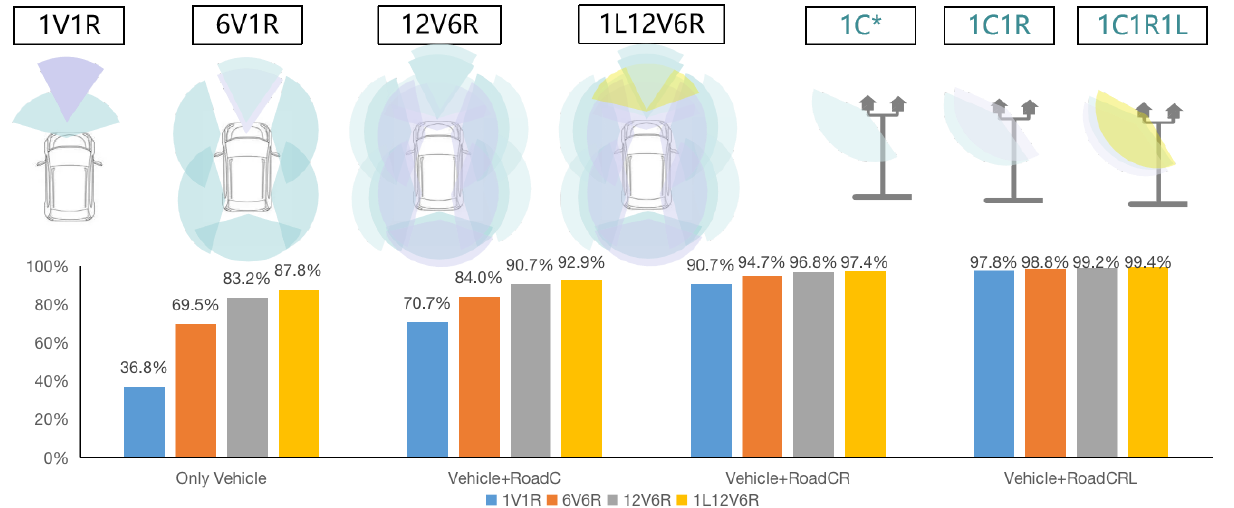
Figure 5. Compre hensive collision avoidance effectiveness of “atomic” technology combinations based on V2X (*C stands for roadside cameras; Light blue stands for camera, light purple stands for radar, light yellow stands for LiDar).